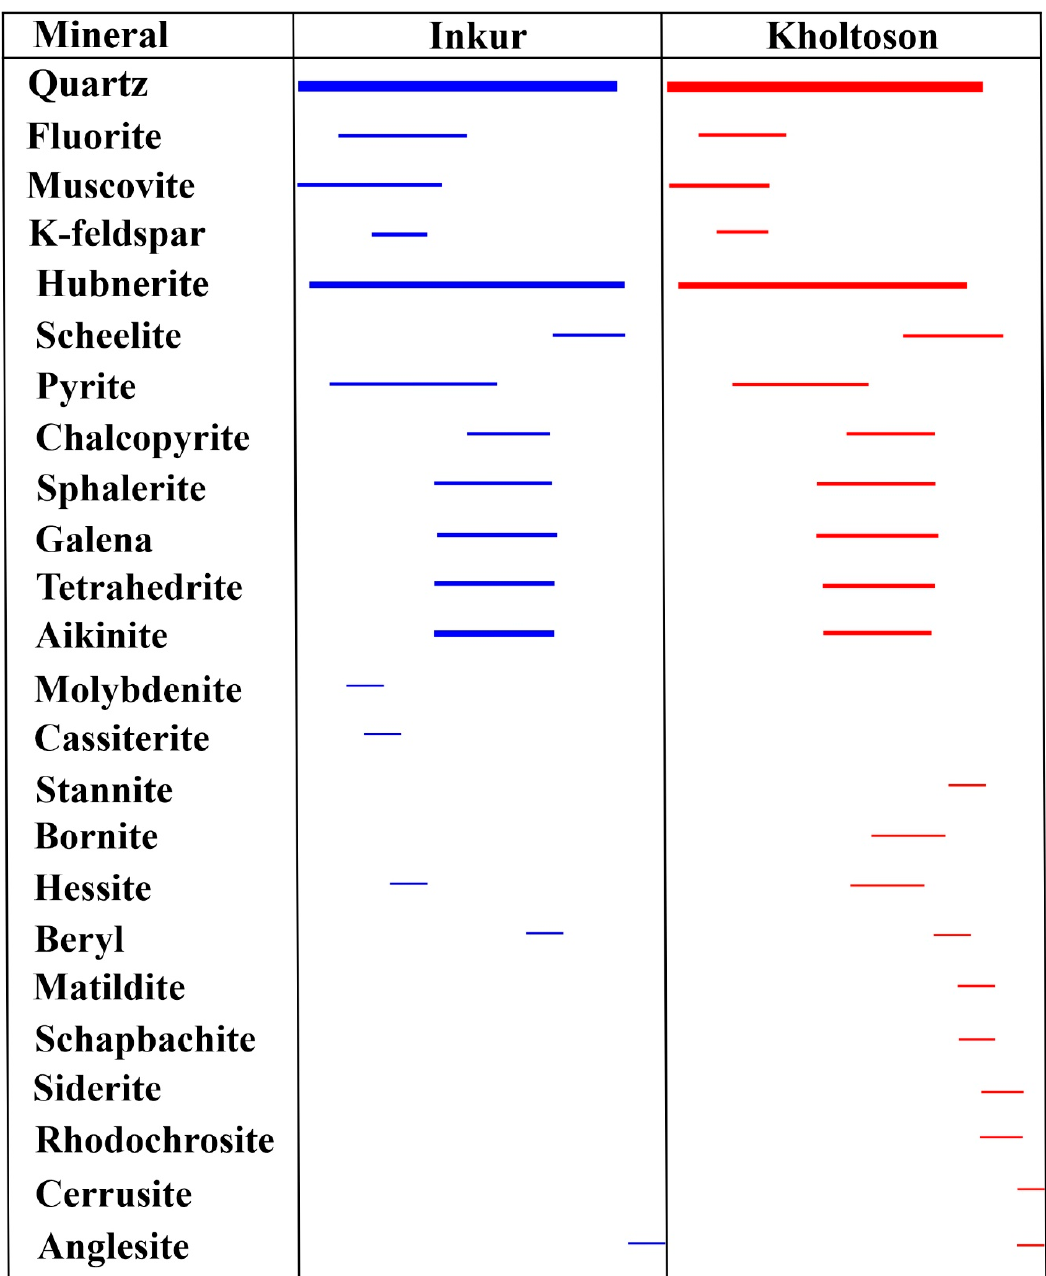
Figure 4. General paragenetic sequence of the Inkur and the Kholtoson deposits. In addition, such minerals as topaz (Al 2 [SiO 4 ](F, OH) 2 ), lindströmite (Pb 3 Cu 3 Bi 7 S 15 ), hammarite (Pb 2 Cu 2 Bi 4 S 9 ), sulfobismuthite of Cu and of Ag, and rare silver and gold tellu- rides (petzite and sylvanite) in assemblage with native gold were identified by previous researchers [31].